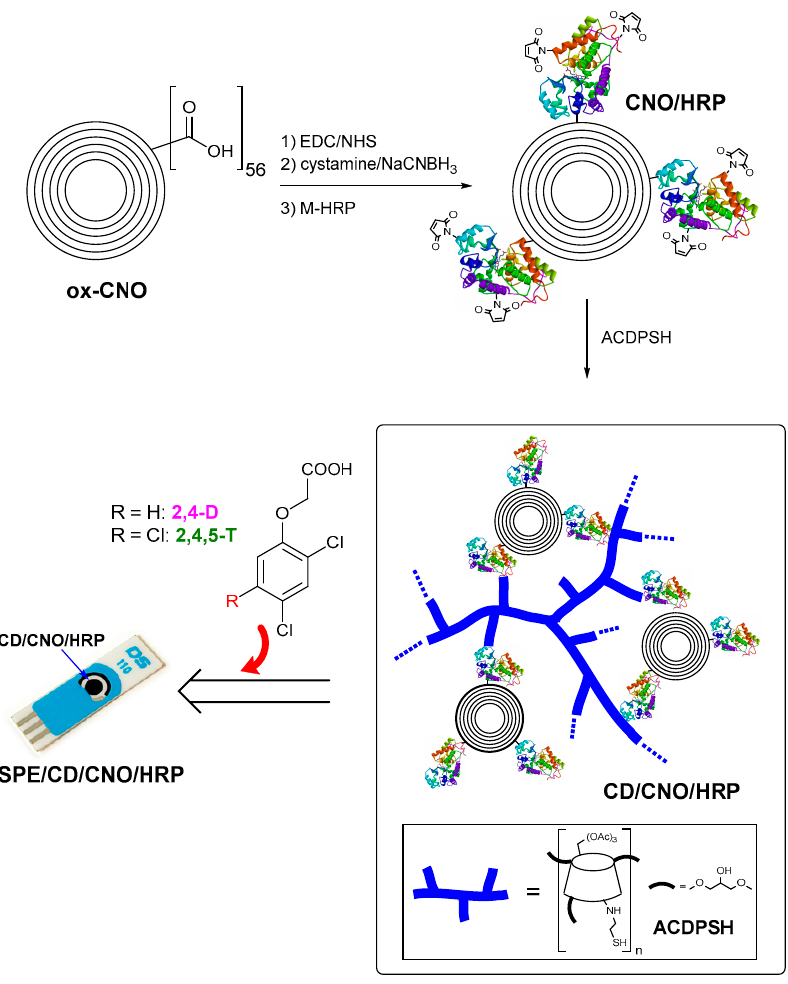
Figure 3. Preparation of SPE/CD/CNO/HRP electrodes.